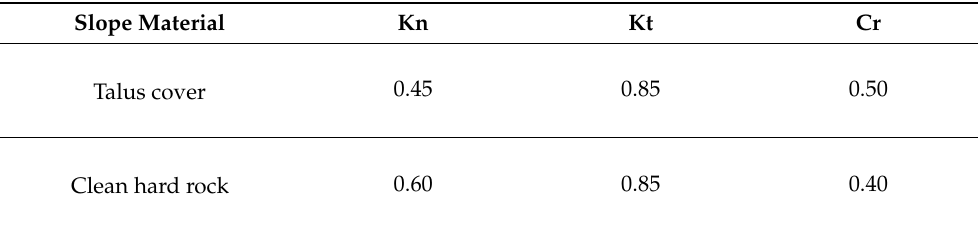
Table 1. Input parameters to define the rockfall trajectories: Kn.—coefficient of restitution of normal en- ergy; Kt.—coefficient of restitution of tangential energy; Cr.—friction coefficient of the rolling